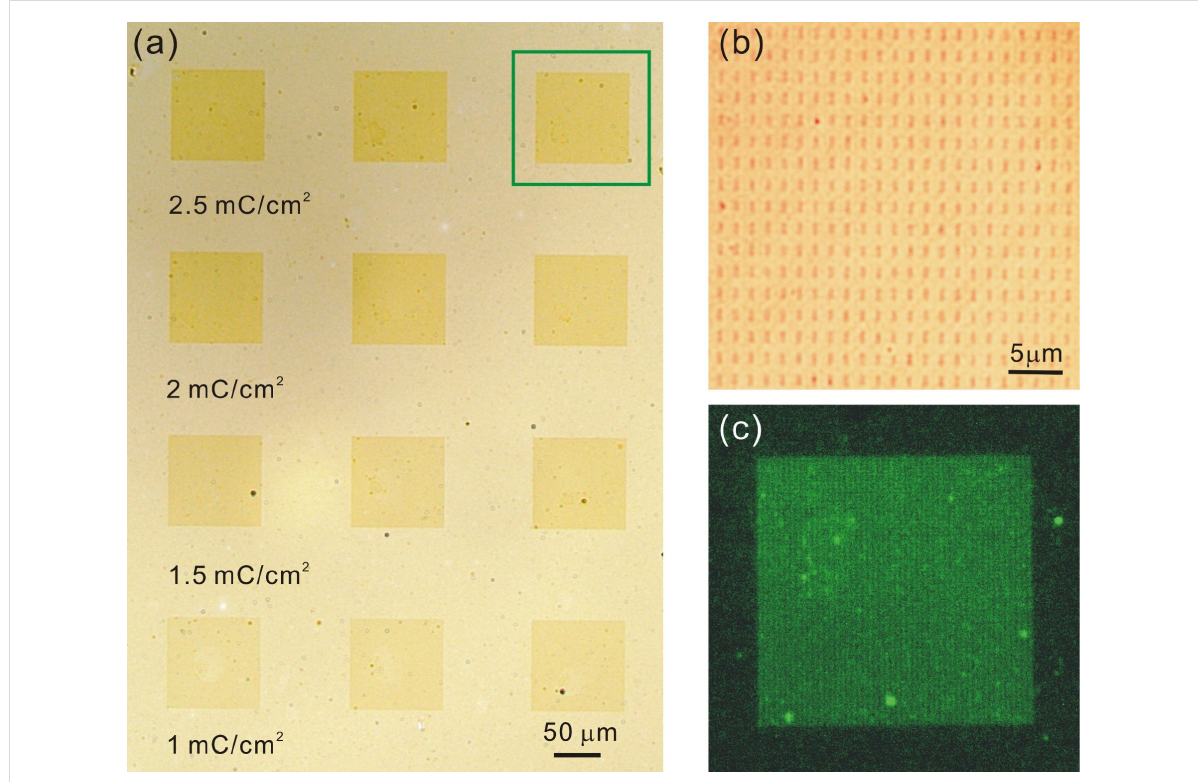
Figure 8: Patterned deposition of [Zn 2 (adc) 2 (dabco)] by using the irradiation-promoted exchange reaction (IPER) to modify the surface chemistry of the SAM. (a) Square arrays of rectangles (1 × 0.3 µm 2 ) were written into the HDT SAM by using different area doses (increasing from bottom to top), followed by exchange with MHDA, before the layer-by-layer growth of the MOF was performed. (b) Close-up of one of the arrays (area dose: 2.5 mC/ cm 2 ) showing the small rectangular deposits of [Zn 2 (adc) 2 (dabco)]. (c) Epifluorescence image (excitation wavelength 475 nm) of the region marked by the green square in